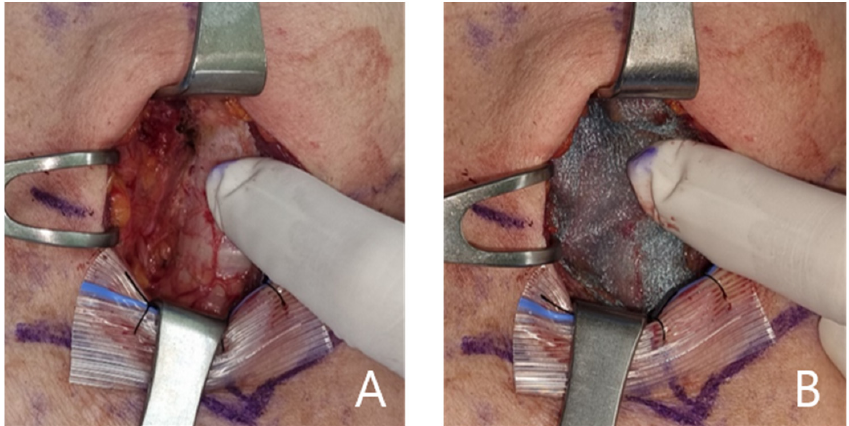
Figure 1. ( A ). Application of fibrin glue on the lymph node dissection site (control group). ( B ). Application of a polyglycolic acid mesh (Neoveil™) after applying fibrin glue on the lymph node dissection site (treatment group).